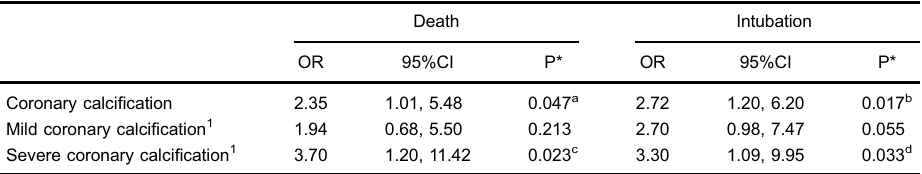
Table 4. Association between coronary calci fi cation and death or mechanical ventilation due to respiratory failure adjusted by multiple confounders.